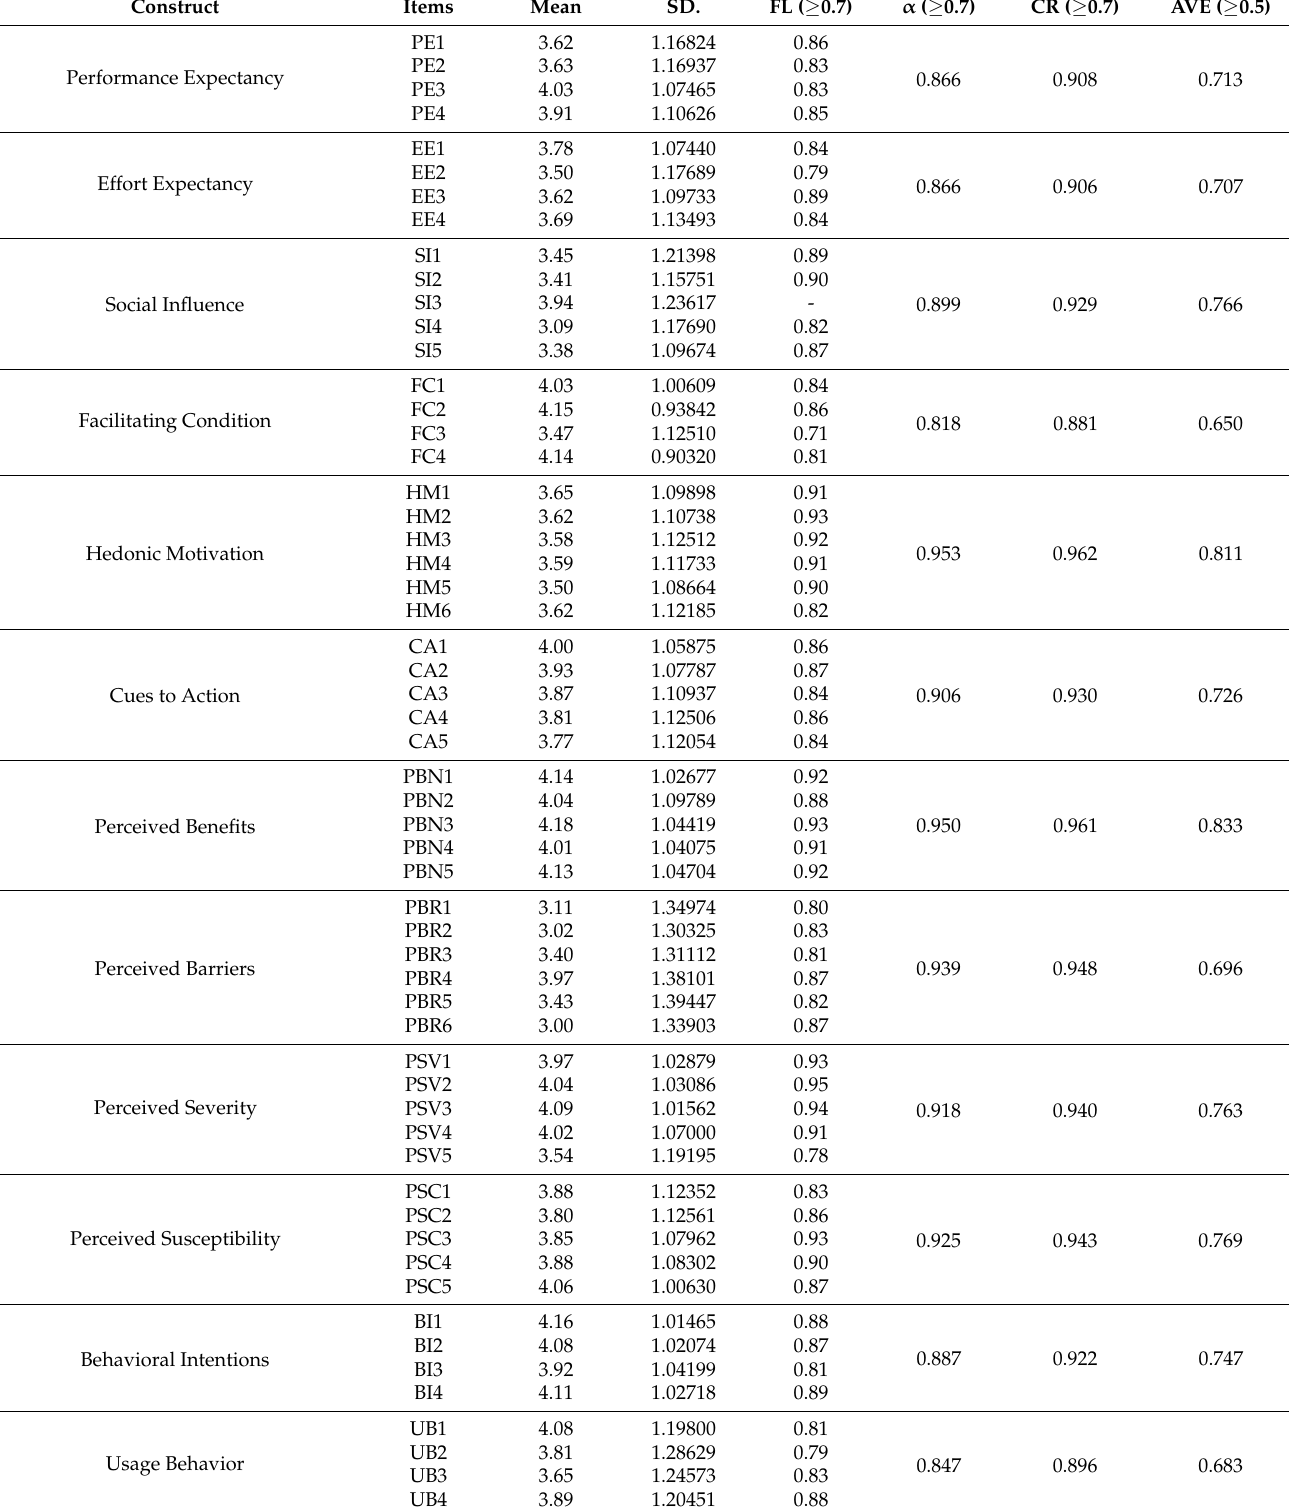
Table 5. The reliability and convergent validity